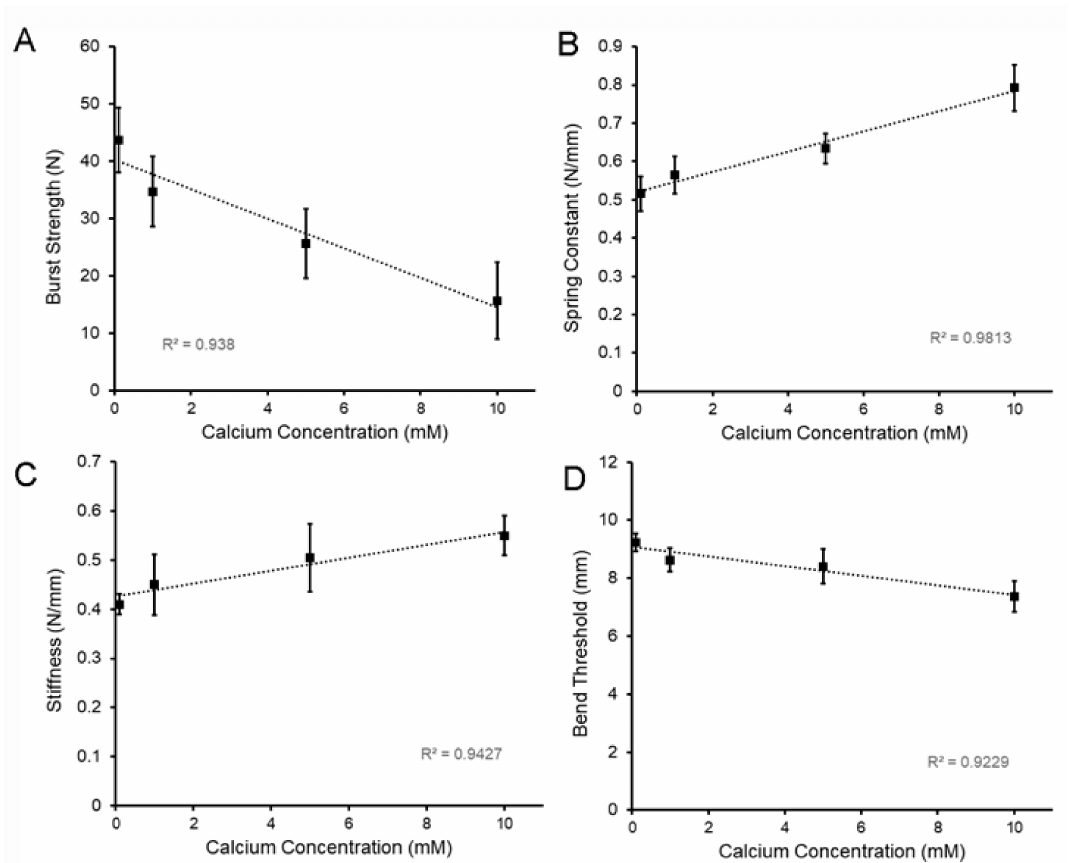
Figure 6. E ff ect of the calcium concentration on the physical properties of LMP films. The LMP films were cured to a 15.7 ± 6.6% ( w / w ) water content; mean values of a minimum of 10 films are shown. ( A ) Burst strength of the films, reflecting the fracture resistance to a uniaxial load applied at a velocity of 0.5 mm / s (see Figure 3), decreased with an increasing calcium concentration (R 2 = 0.938). ( B ) The spring constant, measured as the film displacement and applied force in the 3-point bend test, increased with an increasing calcium concentration (R 2 = 0.9813). ( C ) Similarly, the sti ff ness, measured as the resistance to both the fracture probe and the 3-point bend test (see Figures 2 and 4), increased with an increasing calcium concentration (R 2 = 0.9427). ( D ) The bend threshold, measured as the probe distance at the yield point in a modified 3-point bend test, decreased with an increasing calcium concentration (R 2 = 09229). Error bars = 1